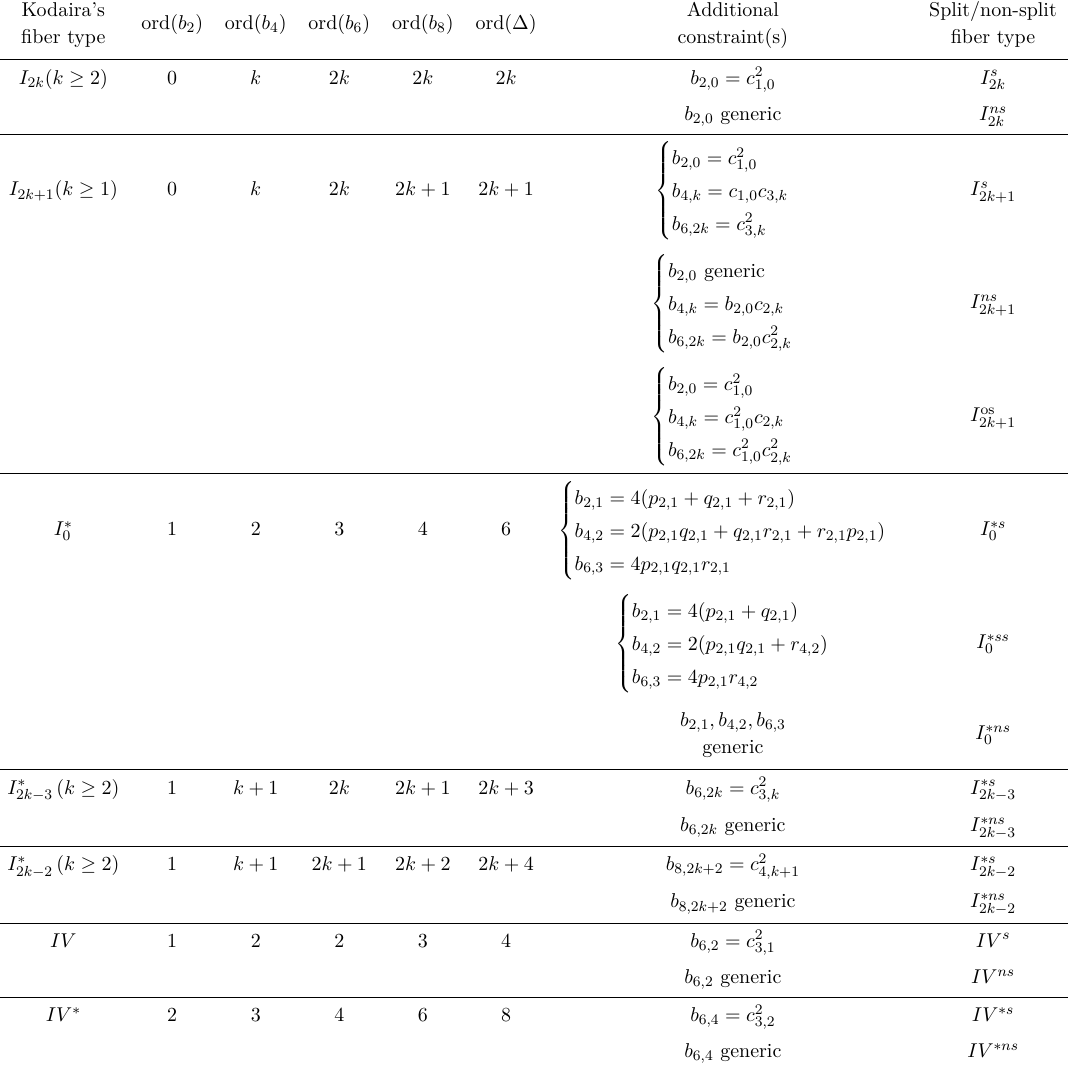
denotes the 2 k +1